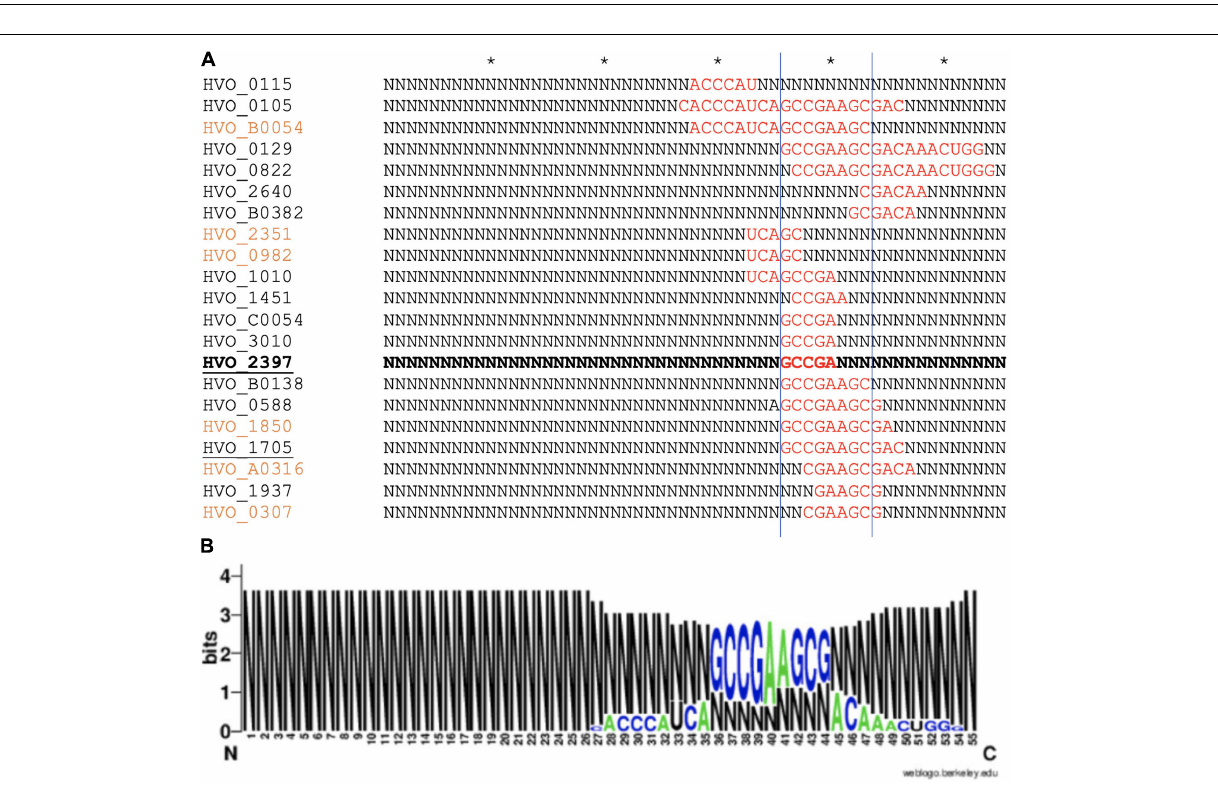
FIGURE 9 | Predicted s479–target interaction sites for proteomic targets. (A) Results of the IntaRNA prediction of interacting sequences of s479 (Mann et al., 2017). The respective targeted mRNA is given at the left, and for the s479 sequence, all nucleotides not taking part in the predicted interaction (red) are depicted as N. The asterisk shown in the upper line marks 10 nucleotides. The proteomic targets included are those exclusively present or absent in (cid:49) s479 in comparison to H66. The znu A1 interaction site is given in bold, transporter targets are underlined, and targets predicted with seed length > 5 are given in orange. (B) The resulting conserved interaction sequence of s479 with its targets is shown as WebLogo at the right (Crooks,